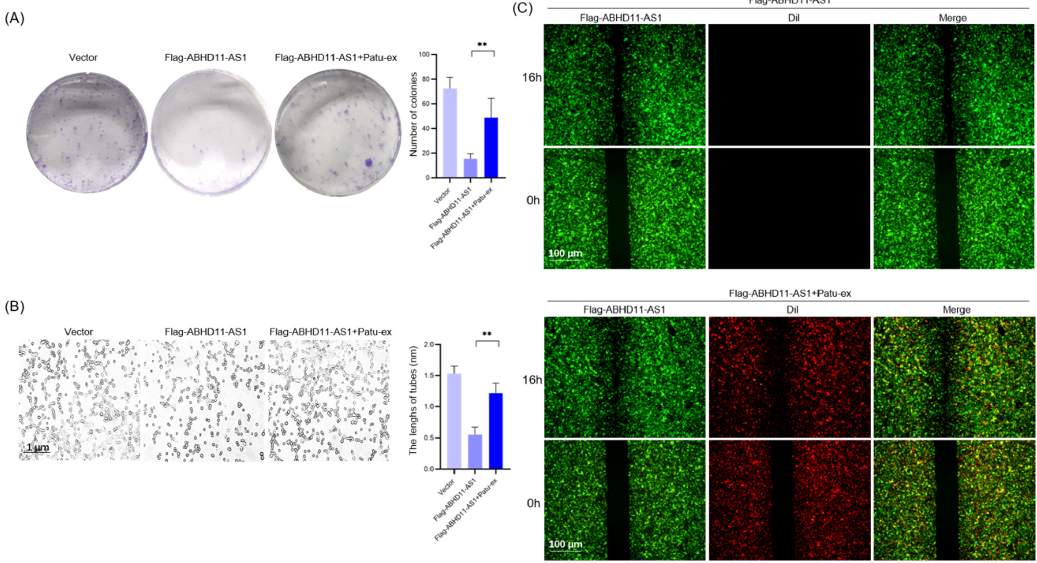
Figure 6. Exosomes from pancreatic cancer cells reversed the inhibitory effect of ABHD11-AS1 on HLECs. The stable HLECs with the overexpression of ABHD11-AS1 were fostered. These cells were cultivated with Patu-ex (400 μ g/mL) for 48 h. ( A ) Colony formation assay was conducted to observe the proliferation of these cells ( n = 3). ( B ) Tube-formation assay was conducted to test the tube- forming ability of these cells ( n = 3). ( C ) Exosomes from Patu8988 were dyed with DIL, and the wound healing assay was conducted to observe the migration of these cells. ** p < 0.01. 3.5. Pancreatic Cancer Cell-Derived Exosomes Can Promote Pancreatic Cancer Cell Proliferation and Lymphatic Metastasis In Vivo After confirming that exosomes derived from pancreatic cancer cells can promote the proliferation, migration, and tube formation of lymphatic endothelial cells in vitro, we also performed in vivo experiments to verify these results. In pancreatic cancer patients with positive and negative lymphatic metastases, we collected tumor tissues from them to perform immunohistochemical experiments. In the tumor tissues, lymphatic vessels were observed to be less enriched, whereas in the adjacent tissues, lymphatic vessels were enriched to a lesser extent. The degree of enrichment was high (Figure 7A). We injected intratumoral exosomes after tumor formation in a nude mouse model. The results sug- gested that exosomes could promote the growth of cancerous tumors. The tumor bodies of these nude mice were significant in size and weight. The same volume of PBS was in- jected into the control group (Figure 7B,C). After slicing the tumor, LYVE-1 immunohisto- chemistry showed that the enrichment of lymphatic vessels in the exosome-injected tumor was higher than that in the control group (Figure 7D). Thus, we showed that pancreatic cancer cell-derived exosomes can promote pancreatic cancer proliferation and lymphatic metastasis in vivo.